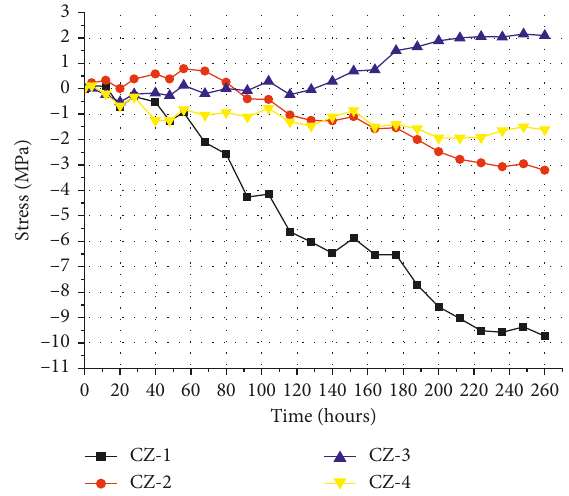
Figure 11: Time history curve of initial support stress of the left tunnel